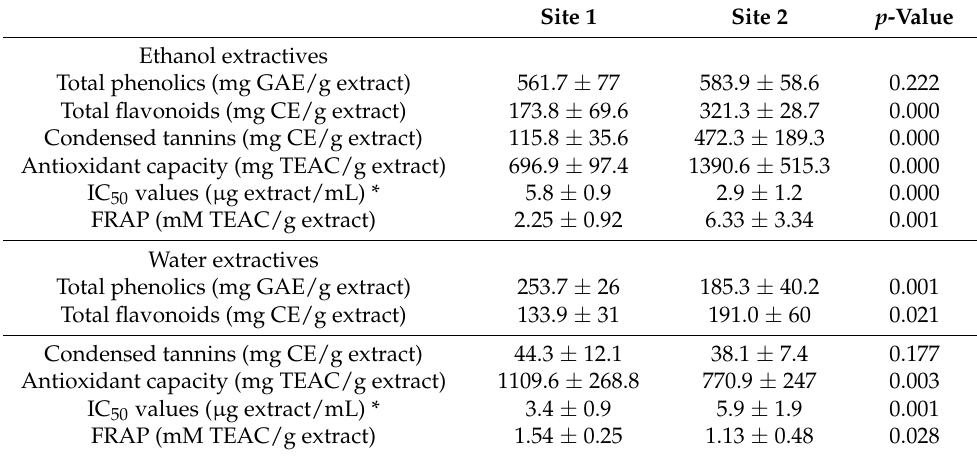
Table 4. Composition and antioxidant capacity of ethanol and water extracts of Quercus rotundifolia bark sampled at b.h. of trees in two sites (mean of five trees and standard deviation). Site 1 Site 2 p -Value Ethanol extractives 561.7 ±